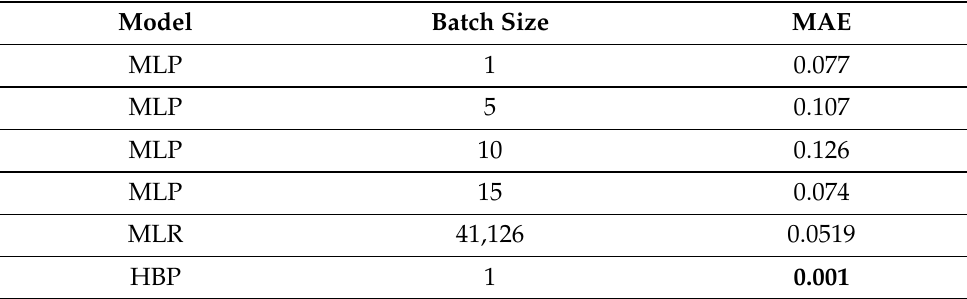
Table 1. Performance comparison between software